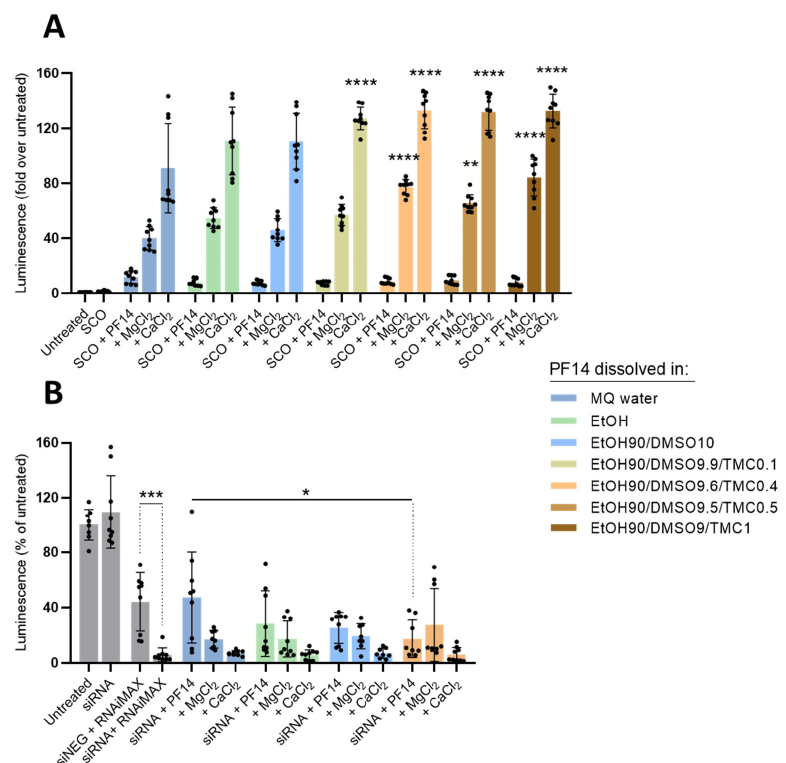
Figure 2. Effect of nanoparticles prepared from SCO or siRNA and differently dissolved PF14 on splicing correction and luciferase silencing, respectively. The 1 mM stock solutions of PF14 were prepared by dissolving the peptide in different solvents and their mixtures, as indicated in legends (proportions are given as v : v ). ( A ) HeLa pLuc 705 cells were incubated for 24 h with solutions containing SCO alone (100 nM), nanoparticles of SCO and PF14 taken at MR 5 (PF14:SCO) with or without the addition of 3 mM CaCl 2 or MgCl 2 . ( B ) U87 MG-Luc2 cells were incubated for 48 h with solutions containing siRNA alone (15 nM), nanoparticles of siRNA and PF14 taken at MR 34 (PF14:siRNA) with or without the addition of 3 mM CaCl 2 or MgCl 2 . As a positive control, siRNA was transfected with Lipofectamine RNAiMAX. In all cases, as a negative control, the cells were incubated with a medium containing 10% ( v : v ) of MQ water (“Untreated”). siNEG—negative, i.e., non-targeting siRNA. Each dataset represents mean ± SD of technical replicates (shown as black dots) from three independent experiments. Data were analysed using one-way ANOVA with post-hoc Tukey’s test. Asterisks indicate statistically significant difference compared to the same solution from “MQ water” group ( A ) or between indicated datasets ( B ), * p -value < 0.05, ** p -value < 0.005, *** p -value < 0.0005, **** p -value < 0.0001.